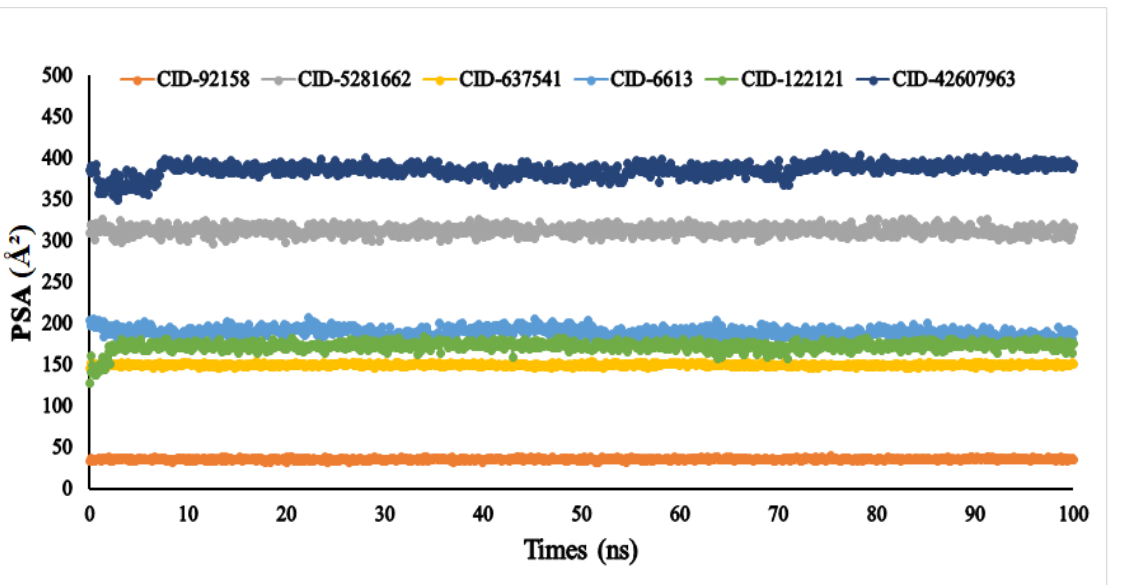
Figure 10. The polar surface area (PSA) of the selected six compounds, viz., lupenone (CID: 92158), swertianolin (CID: 5281662), m -coumaric acid (CID: 637541), pantothenic acid (CID: 6613), phyto- sphingosine (CID: 122121), and 8- C -glucopyranosyleriodictylol (CID: 42607963), in association with the targeted protein α -glucosidase (PDB ID: 3A4A) are shown by specific colour.